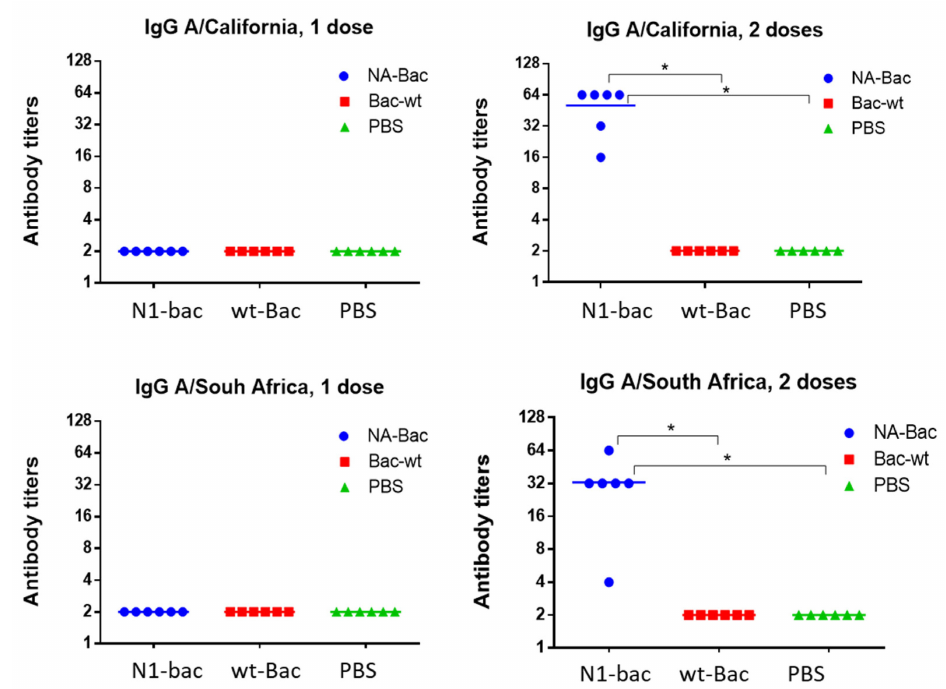
Figure 6. Serum IgG levels to the homologous influenza virus A/California/07/09 (H1N1)pdm09 and the drifted variant A/South Africa/3626/13 (H1N1)pdm09 (n = 6). The results of an ELISA with blood sera were obtained 2 weeks after the 1st and 2nd intramuscular immunizations. *— p < 0.05.